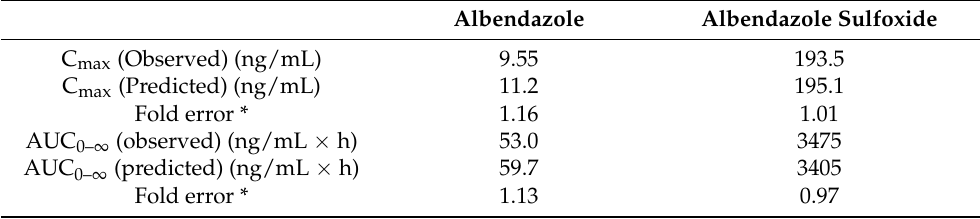
Figure 4. Plot of observed vs. predicted plasma concentration profile of ABZ ( left ) and ABZ_SO ( right ) in healthy volunteers. Table 3. Observed and predicted pharmacokinetic parameters for ABZ and